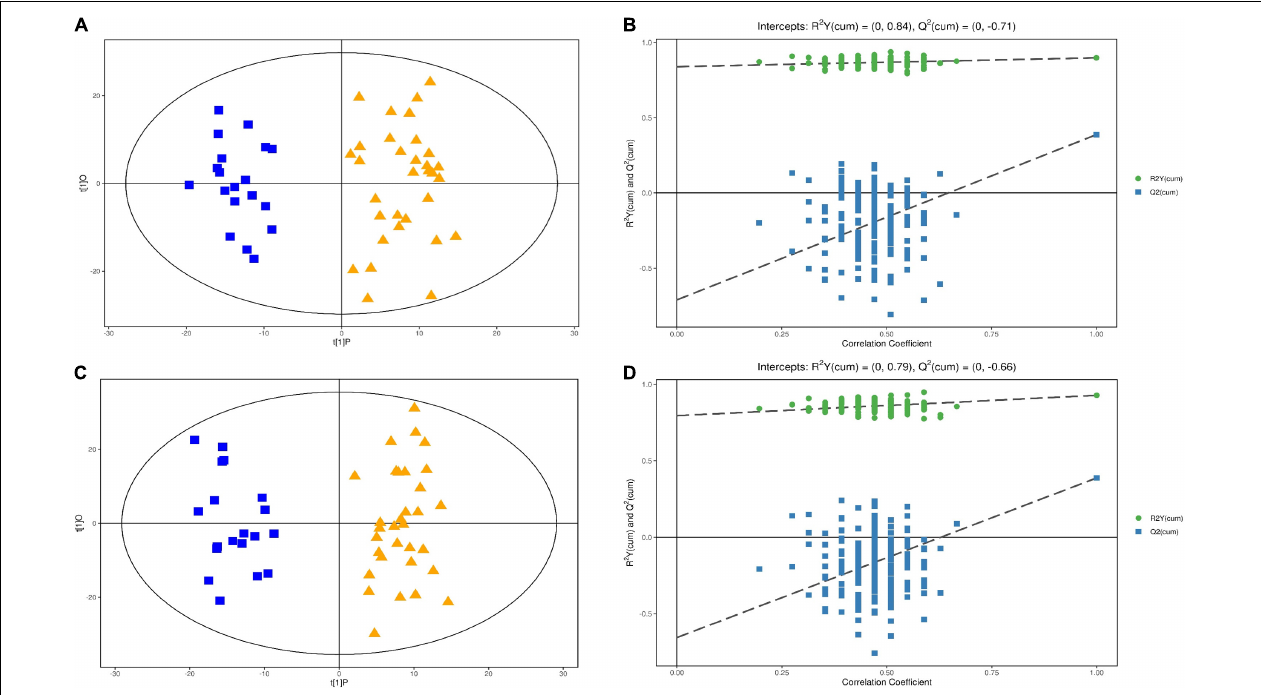
FIGURE 2 | Multivariable analysis and selection of discriminant variables with both positive and negative ion modes between the EA group and the non-EA group. (A,C) Revealed the OPLS-DA score plots with further permutation tests (B) in the positive mode and (D) in the negative mode] between the two groups.